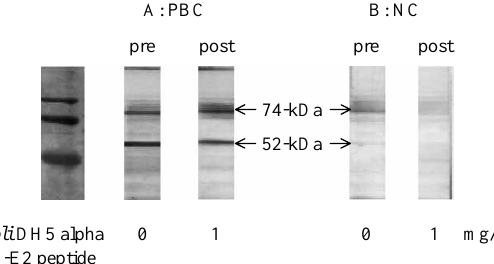
Figure 4. Adsorption tests. Sera were tested at IB after preincubation with the synthetic E. coli peptide. Reactivities with the 74 and 52kDa proteins were visible after adsorption of the PBC serum (panel A) while reactivities were lost in the NC serum (panel B).